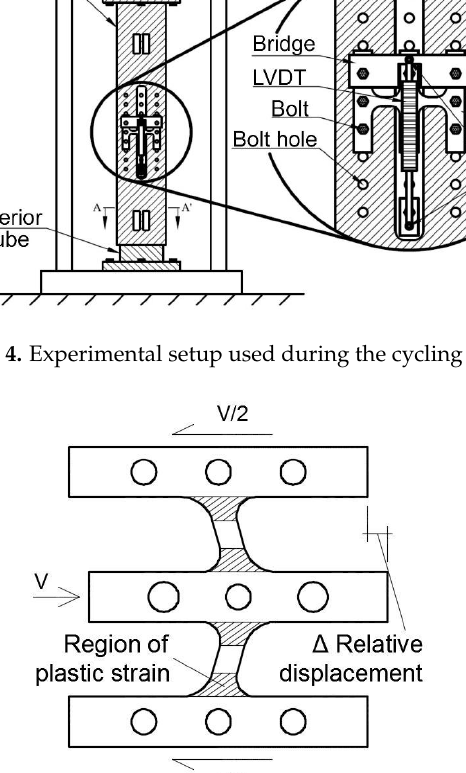
Figure 5. Relative displacement between external and central flanges.